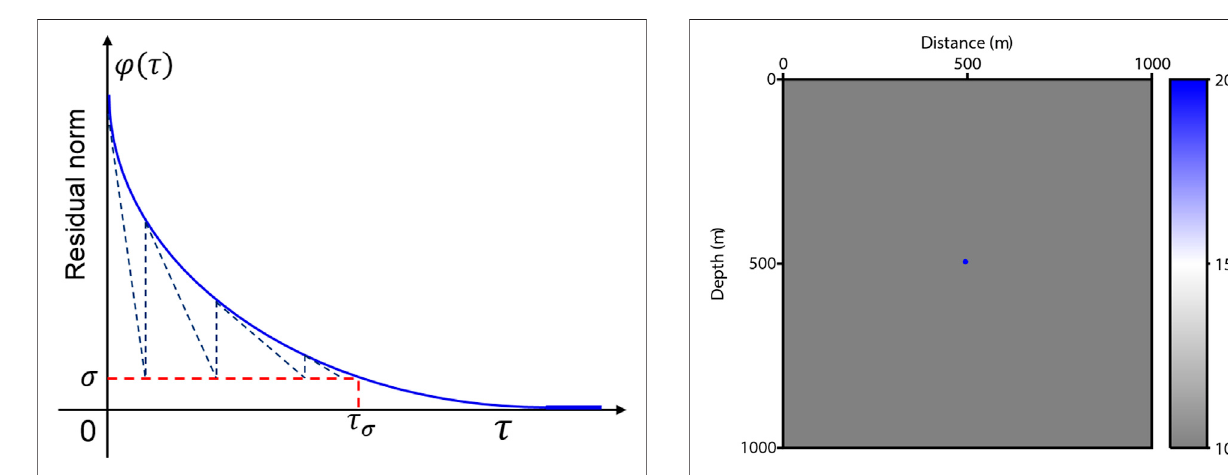
FIGURE 4 | A simple diffraction point velocity